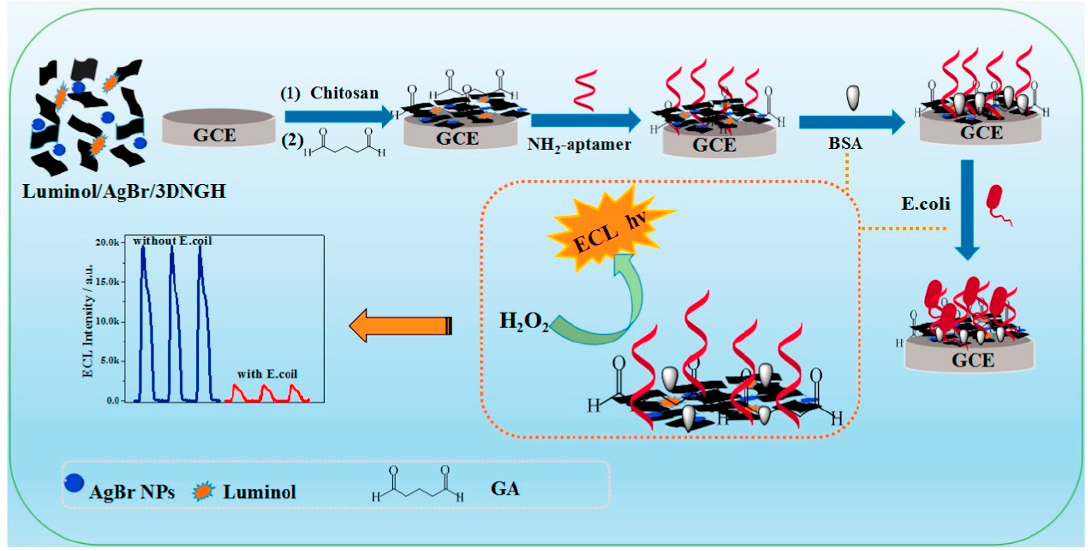
Figure 5. Schematic representation related to the ECL Escherichia coli biosensor, fabricated with luminol/AgBr/3DNGH. Reprinted with permission from [116] Copyright 2017 Elsevier.